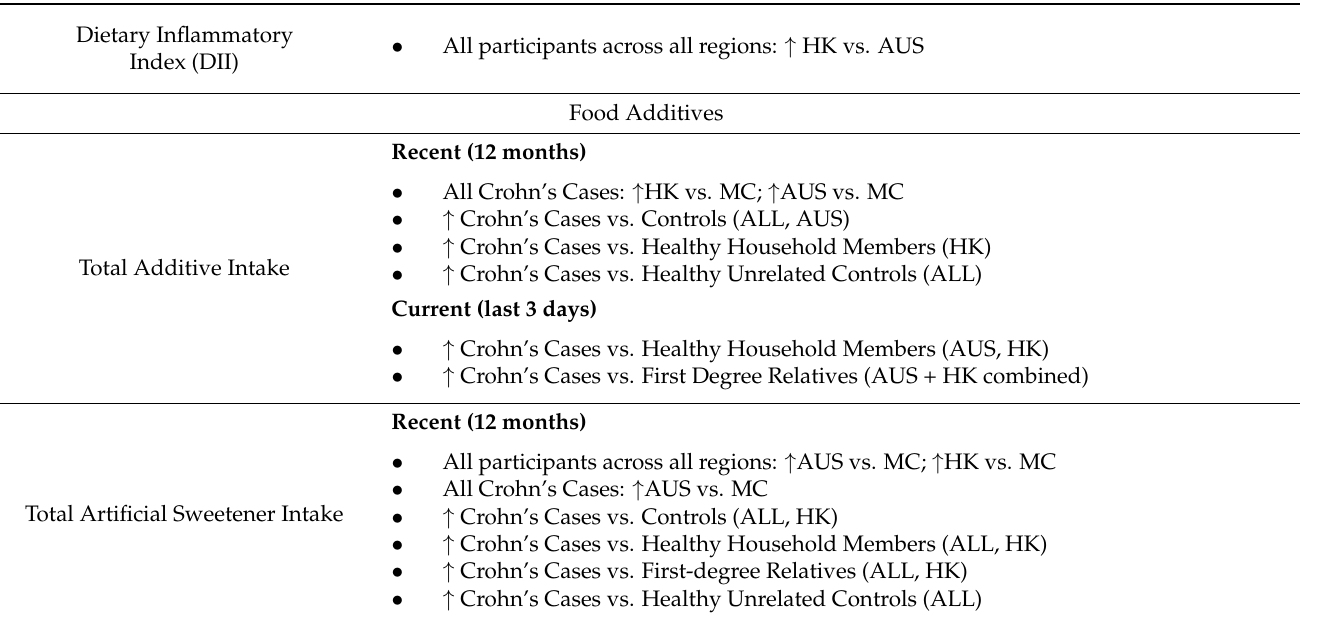
Table 3. Summary of significant differences in usual recent 12-month food additive intake across regions and between Crohn’s disease participants and various